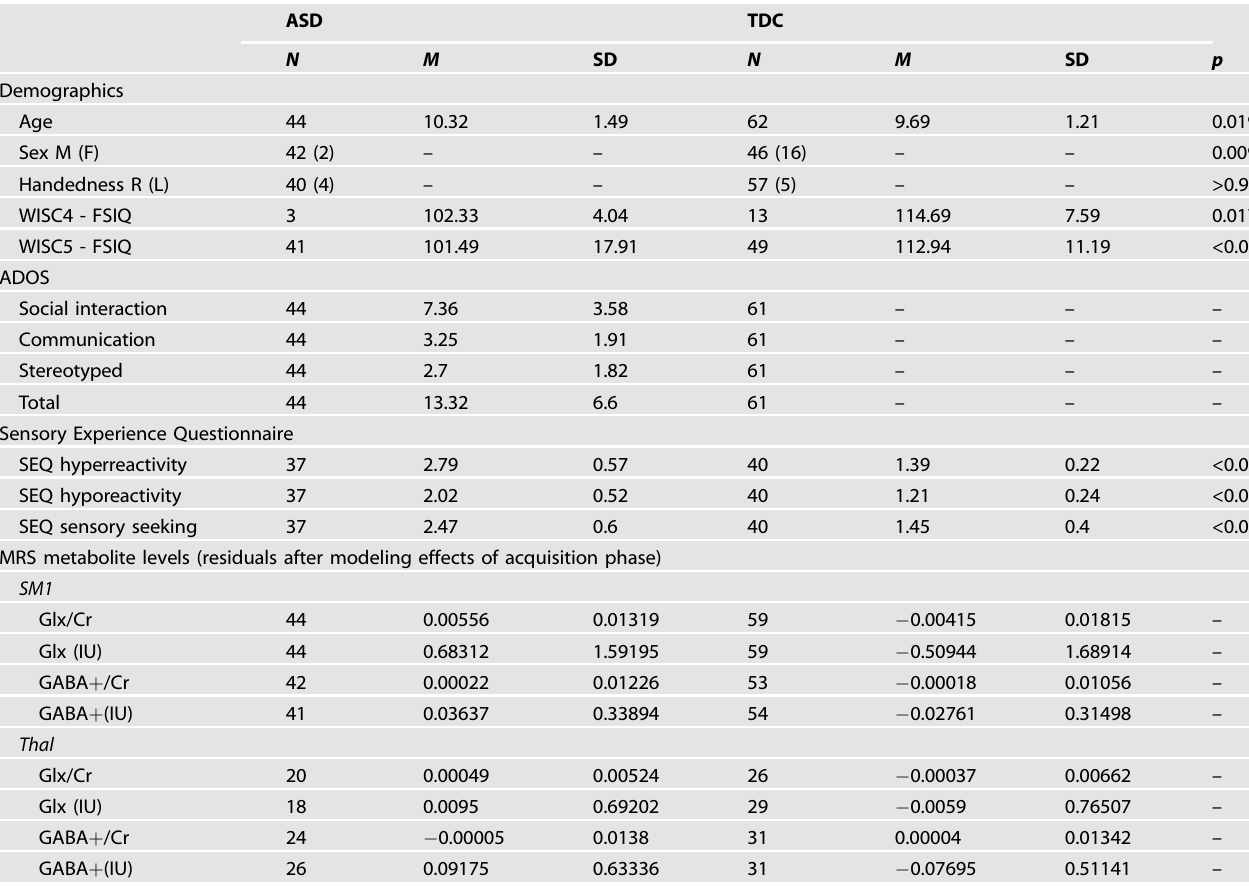
Table 1. Descriptive statistics for demographic variables and key clinical